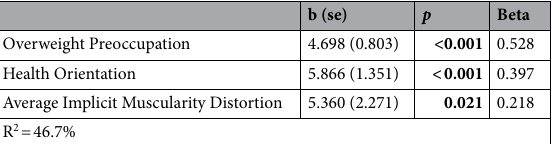
Table 5. Multivariate regression predicting EHQ scores. Significant results are indicated in bold